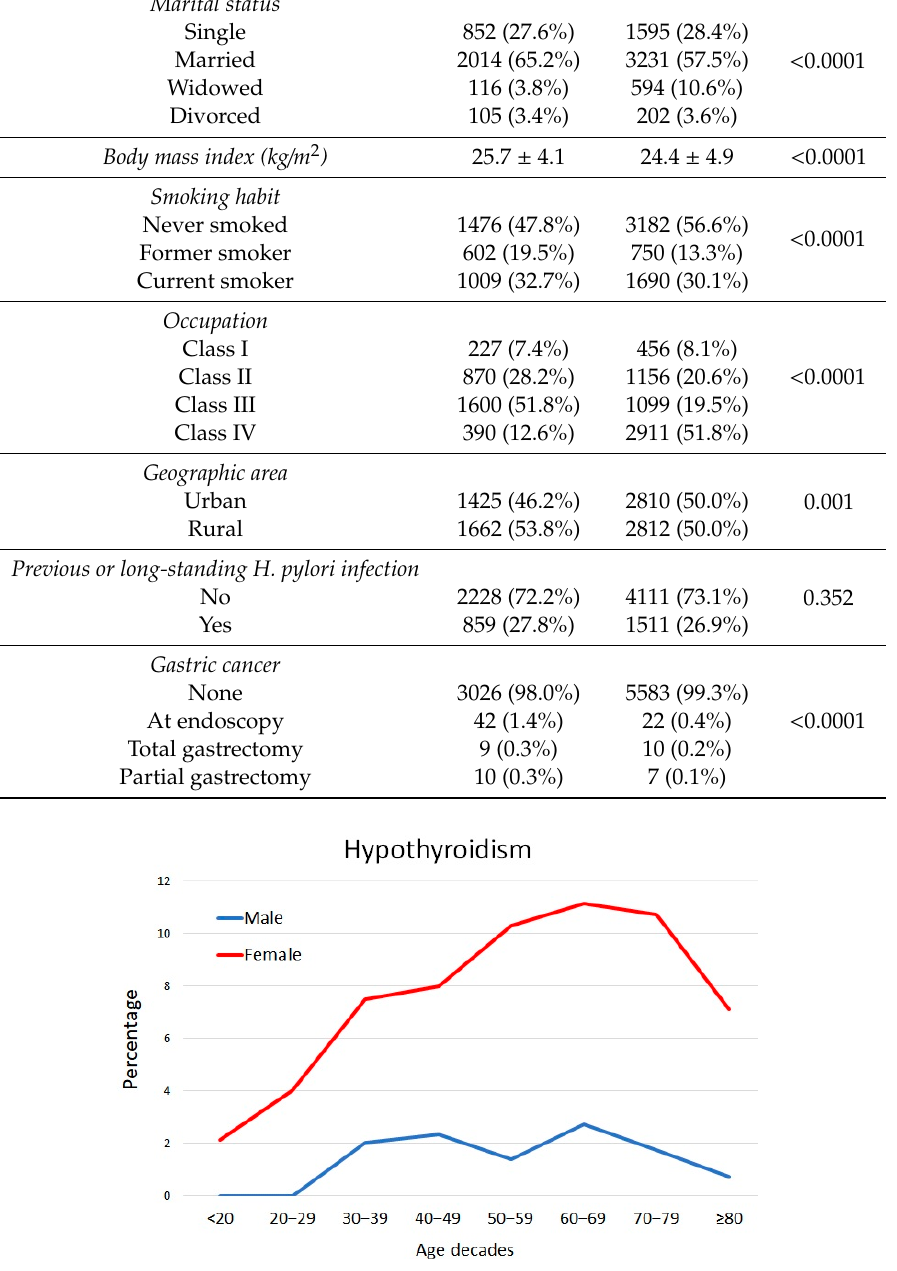
Figure 1. Levothyroxine use by age decades in males and females participating in this study.